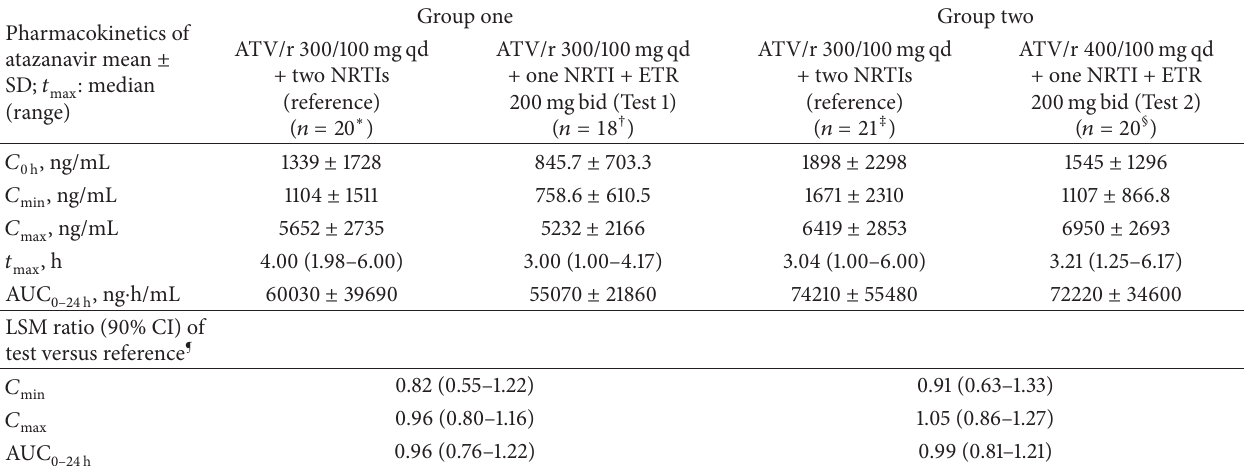
Table 2: Pharmacokinetic parameters and statistical analysis of atazanavir after administration of atazanavir/ritonavir 300/100 mgqd for two weeks in combination with two NRTIs (Day − 1), followed by administration of etravirine 200 mg bid for two weeks in combination with one NRTI and atazanavir/ritonavir 300/100mg qd or atazanavir/ritonavir 400/100mg qd (Week 2).